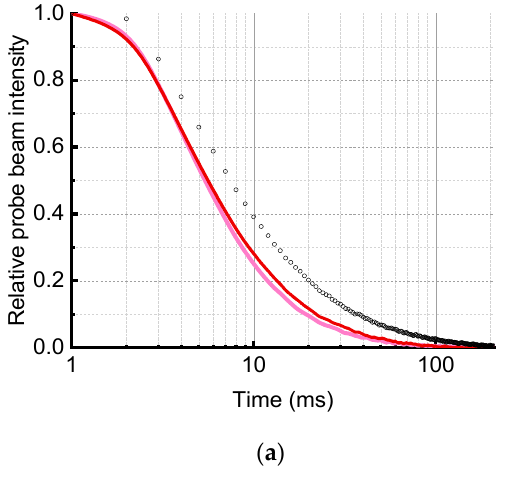
Figure 11. Normalized averaged transient thermal-lens dissipation curves ( a ) for ferroin (red line) and hemoglobin cyanide (dark red line) with the same absorbance in 3 M NaCl; ( b ) albumin solutions of various concentrations (no albumin, green; 20 g/L, blue; and 50 g/L, magenta) with the addition of ferroin (10 µM in a solution of 0.9% NaCl); for clarity, the X-axis is shown in the logarithmic scale. Setup, excitation wavelength, 514.5 nm; excitation power, 40 mW. The delay of the dissipation start is caused by closing the mechanical shutter.